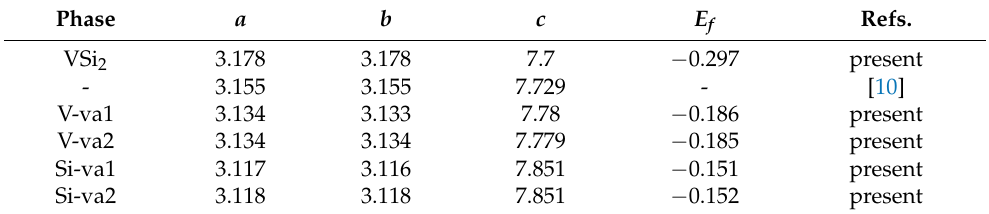
Table 1. The lattice parameters and vacancy formation energy E f (eV/atom) of C11 b -VSi 2 with vari- ous vacancies.